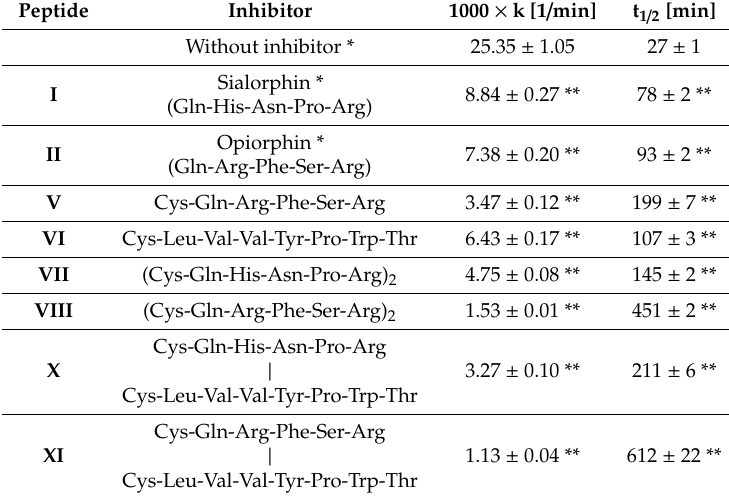
Table 2. Degradation rates (k) and half-lives (t 1 / 2 ) of Met-enkephalin incubated with neutral endopeptidase (NEP) alone and with peptides.